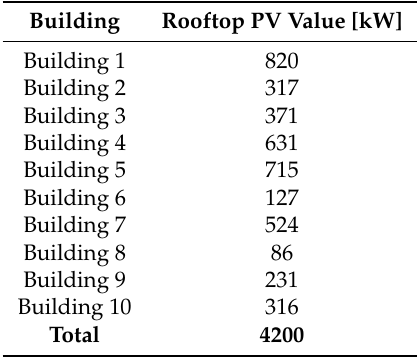
Table 4. Building rooftop PV generation